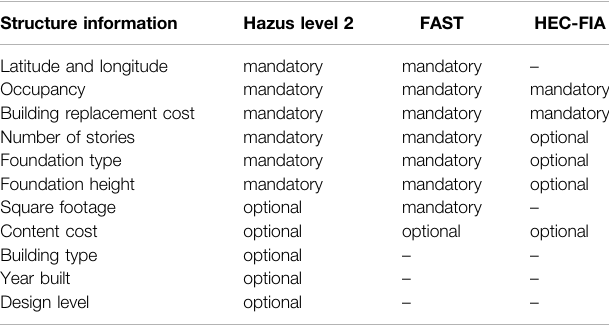
TABLE 4 | Structure information used in the testing of software, and their categorization as mandatory or